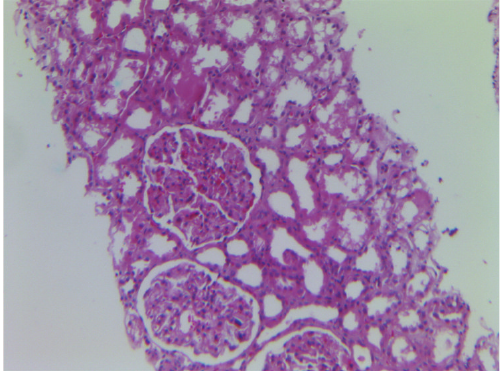
Figure 1: Glomeruli are large and hypercellular with proliferation of cells in the mesangium and leukocytic infiltration.